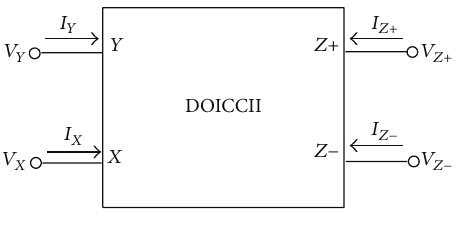
Figure 1: Schematic symbol of DOICCII.